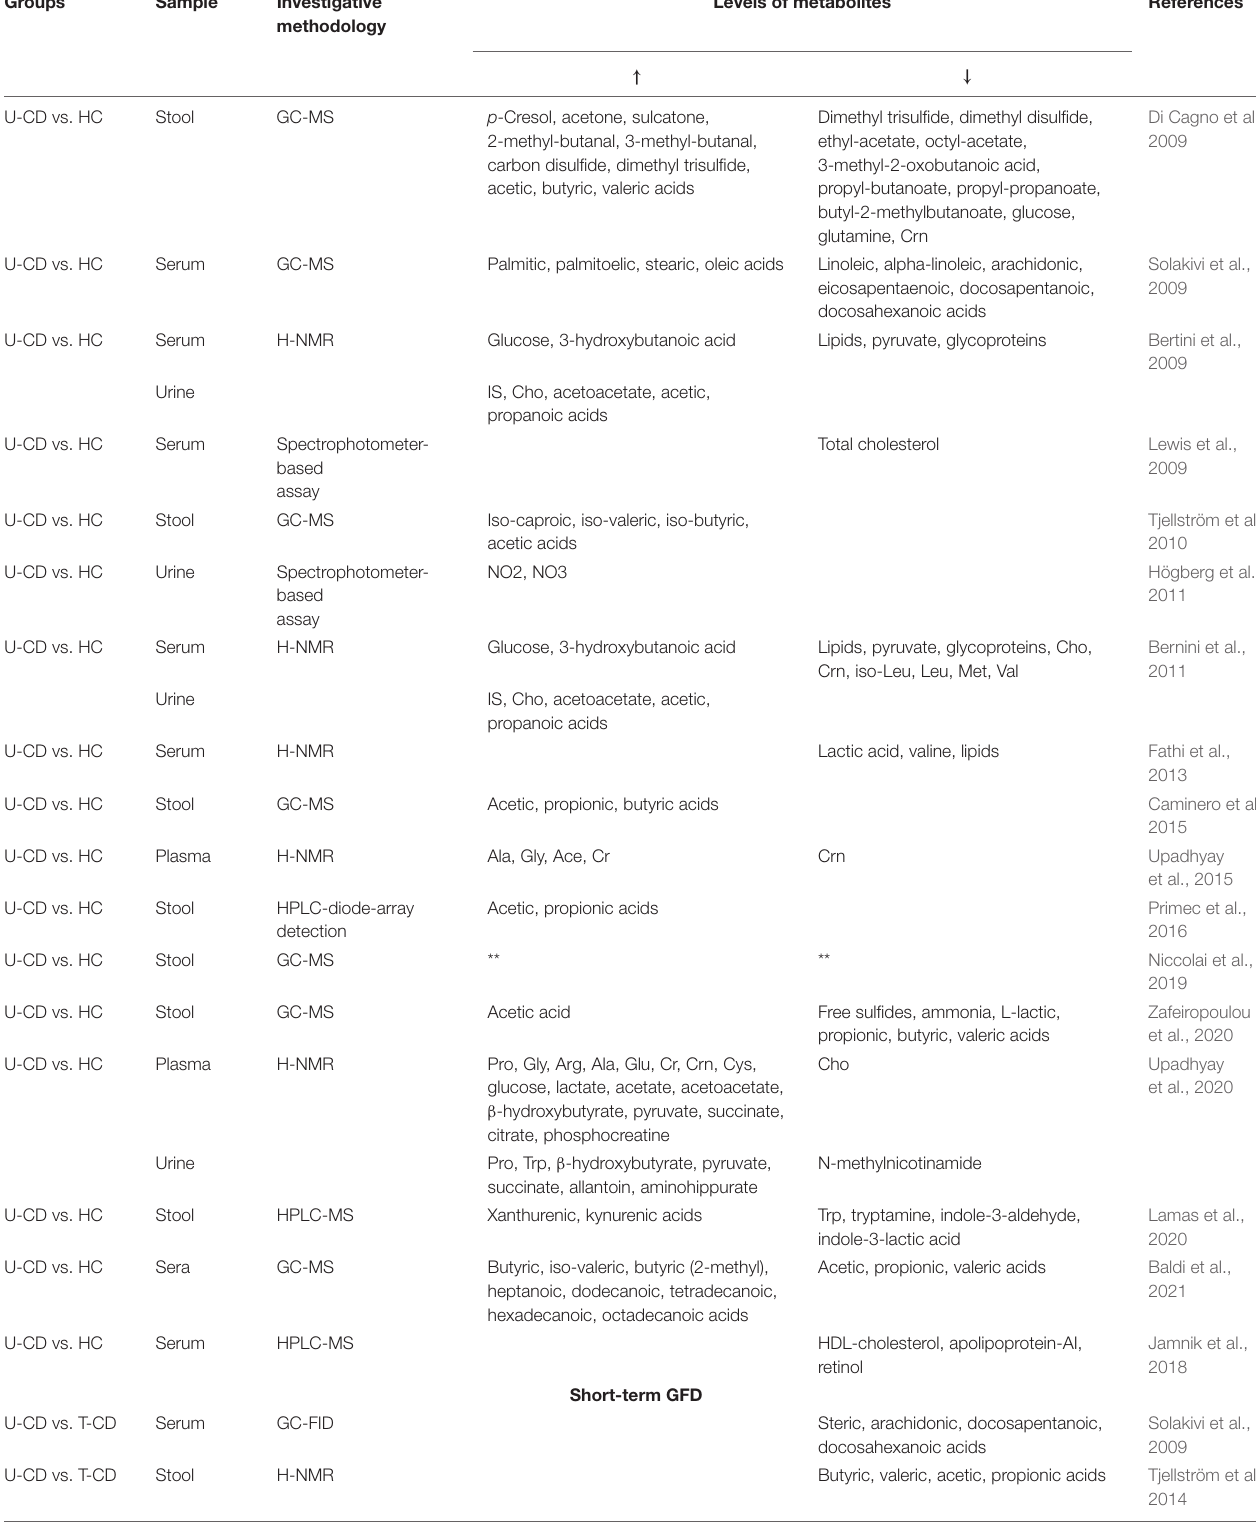
TABLE 1 | Summary of metabolite variations for different types of biological samples in selected studies.